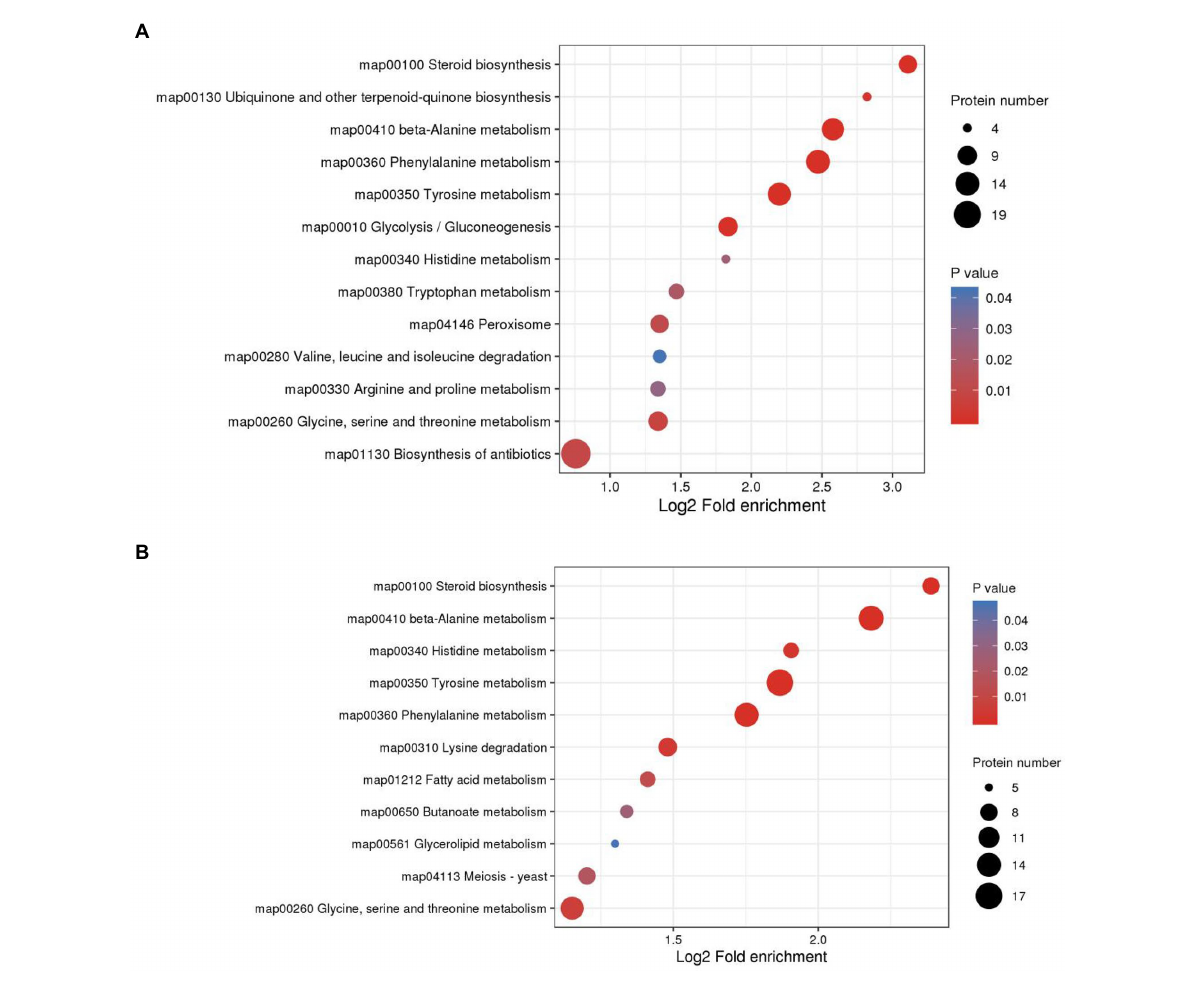
FIGURE 7 KEGG enrichment analysis was performed for each protein class and the enrichment results for different classifications were combined. The horizontal axis shows fold enrichment after Log2 transformation, the vertical axis shows the functional classification, the bubble size represents the number of proteins, and the bubble color represents the value of p of enrichment significance. (A) KEGG enrichment analysis of DEPs in M0.5 vs. CK. (B) KEGG enrichment analysis of DEPs in M vs.